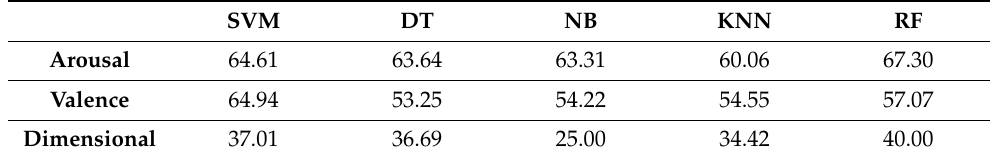
Table 6. ML models’ performance for PPG.